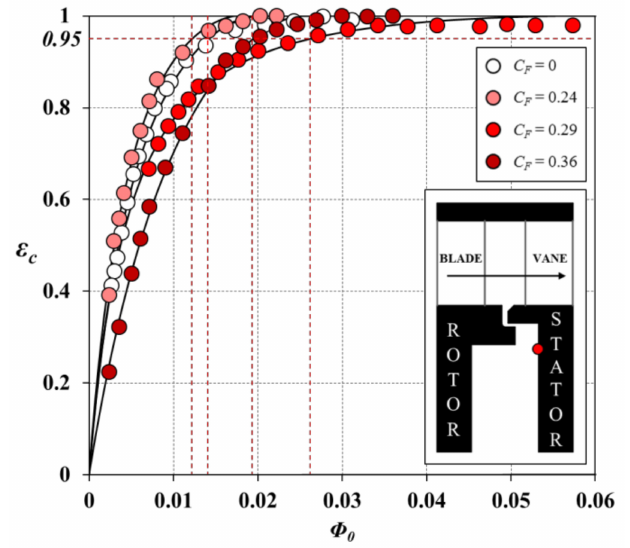
Figure 11. Effect of flow coefficient C F on the variation of ε c with Φ 0 for the single radial-clearance seal in the downstream wheel-space (symbols denote data; lines are theoretical curves red dashed lines indicate the values of Φ min (cid:48) ) ( Re ϕ = 7.2 × 10 5 , r / b = 0.958).